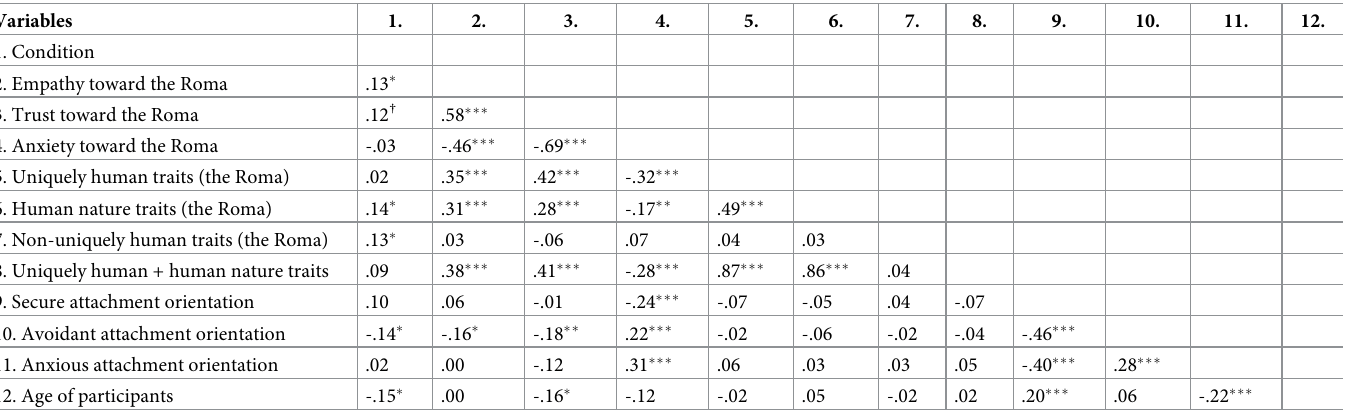
Table 1. Correlations between the main variables of the study (Study